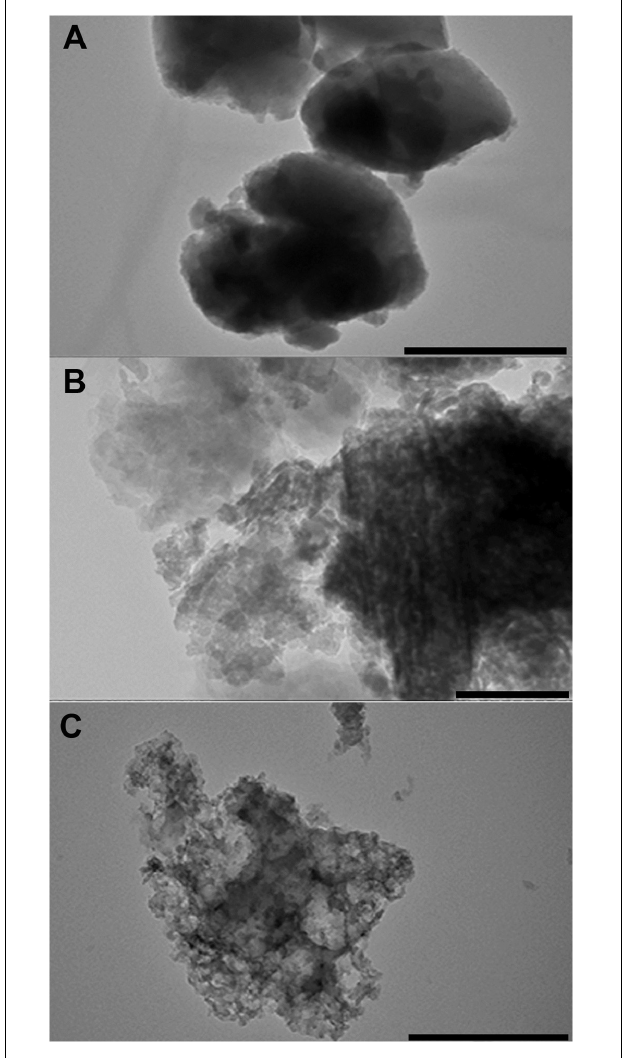
FIGURE 1 | TEM images of three different zeolites (Chabazite – A , Clinoptilolite – B , and Natrolite – C ) grinded in an electric mill up to particles of micrometer size. bar = 200 µ